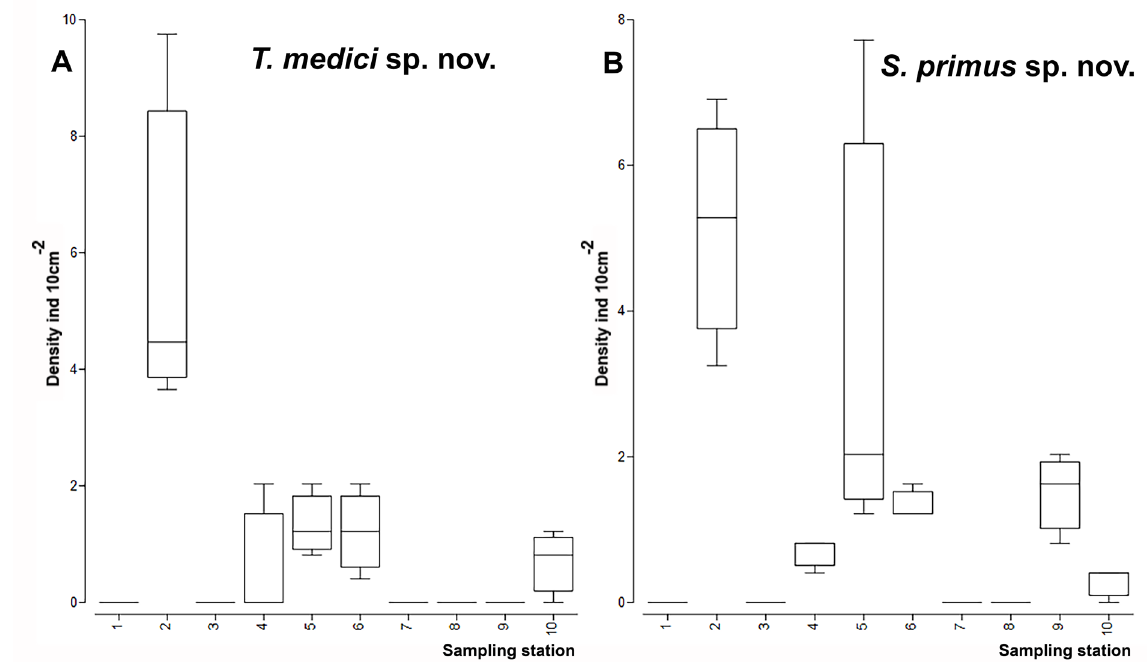
Fig. 20. Mean density values (ind. 10 cm -2 ) of T. medici sp. nov. and S. primus gen. et sp. nov. recorded on 18 Jan. 2019 at the sampling stations along the Urías system. See also Gómez (2020a: 43, fig. 1) . A . T. medici sp. nov. B . S. primus gen. et sp. nov.